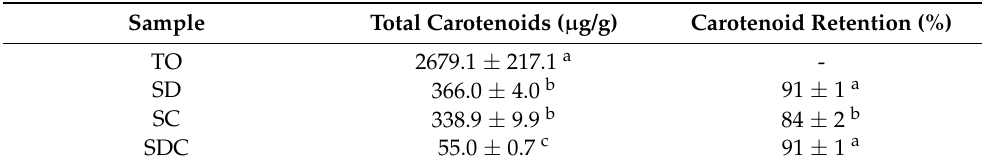
Table 1. Total carotenoid content of tucum ã oil and microparticles obtained by different techniques, as well as carotenoid retention after